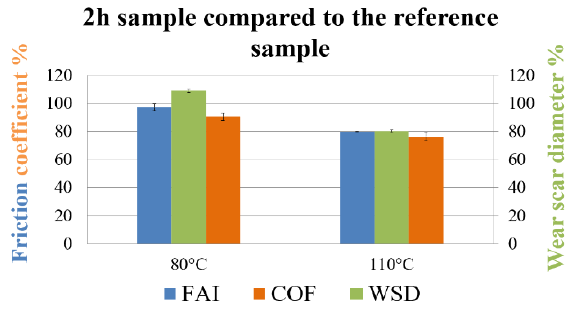
Figure 7. The tribological results of oil sample number 1, compared to the ÖMV 20W50 reference engine oil (figure of the authors)